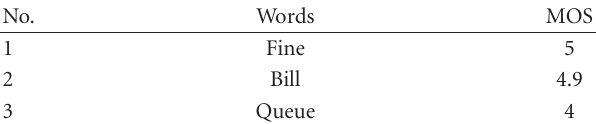
Table 4: MOS for WAV